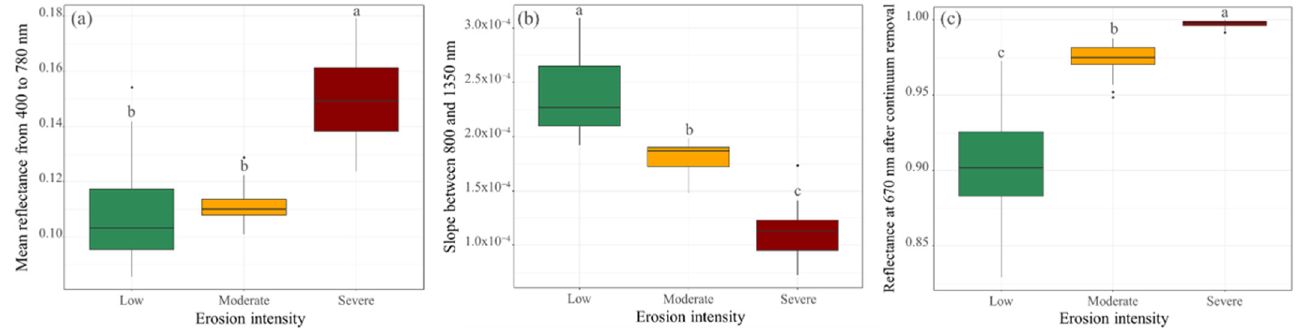
Figure 5. Boxplots of laboratory spectral indices of topsoil used for spectral separation of erosion intensity classes. ( a ) Mean reflectance over the visible region (400–780 nm), ( b ) slope between 800 and 1350 nm, and ( c ) continuum-removed reflectance value at 670 nm. Different letters indicate significant differences among the three groups ( p < 0.05).